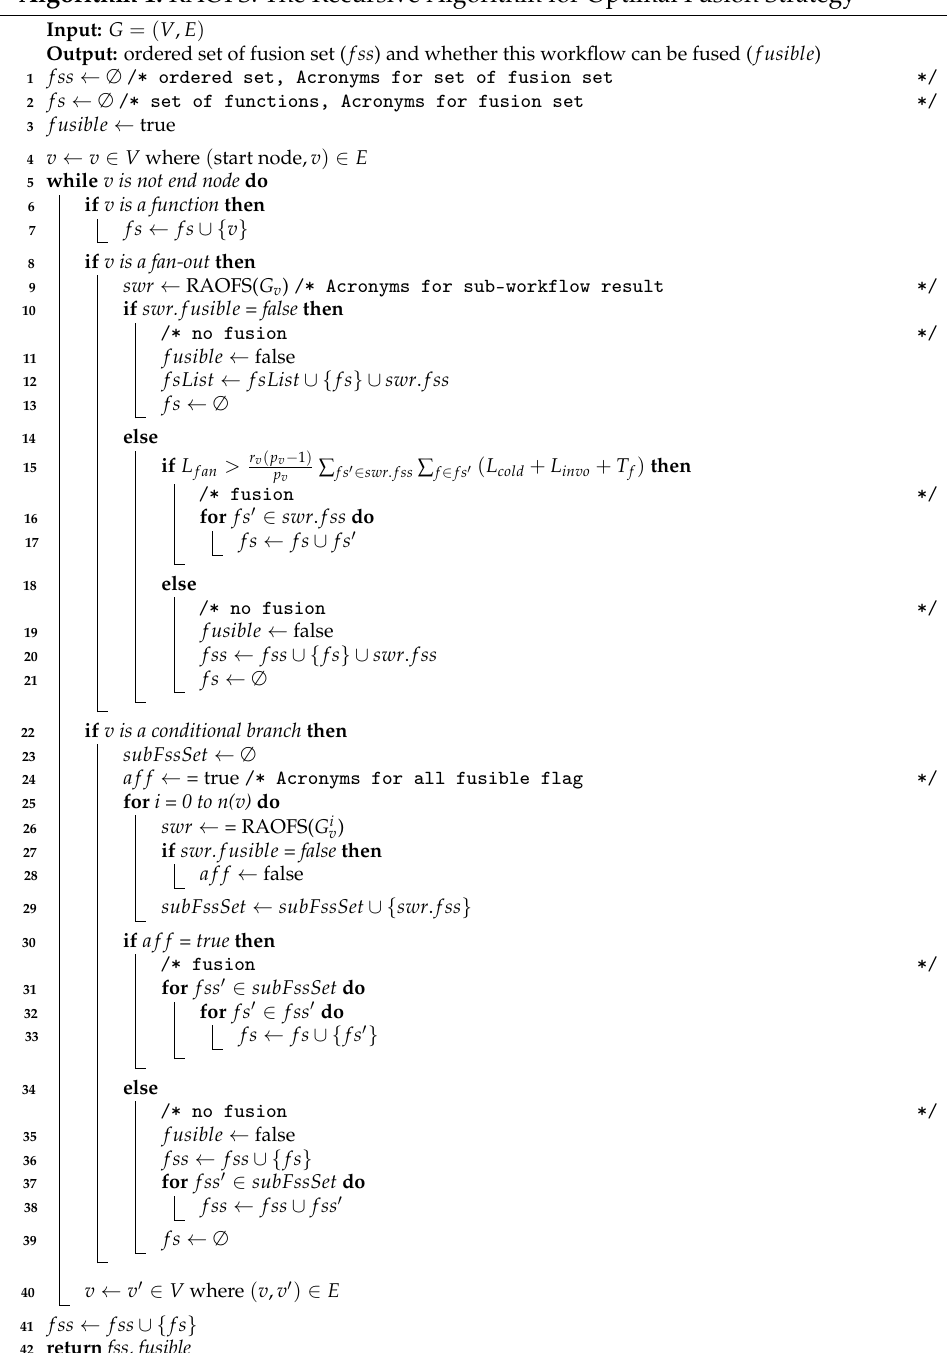
Algorithm 1: RAOFS: The Recursive Algorithm for Optimal Fusion